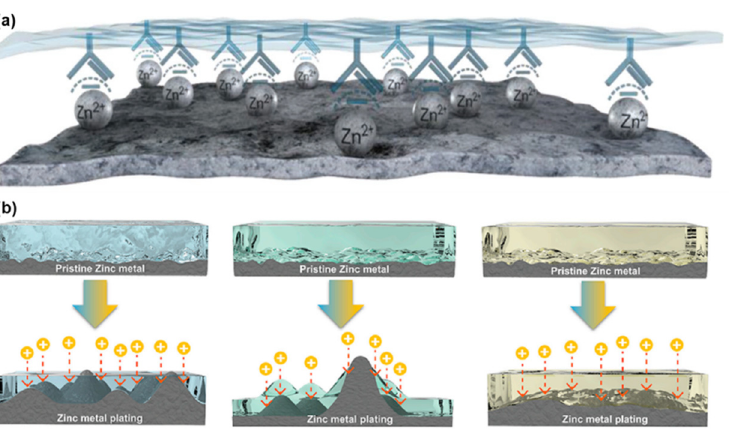
Figure 7. ( a ) Schematic illustration of the formation of quasi-SEI between PANa electrolyte and Zn anode. Reproduced with permission from [34]. ( b ) Schematic illustration of morphology evolution for Zn foils with liquid electrolyte, pure PAM and self-healable hydrogel electrolyte. Reproduced with permission from [64].